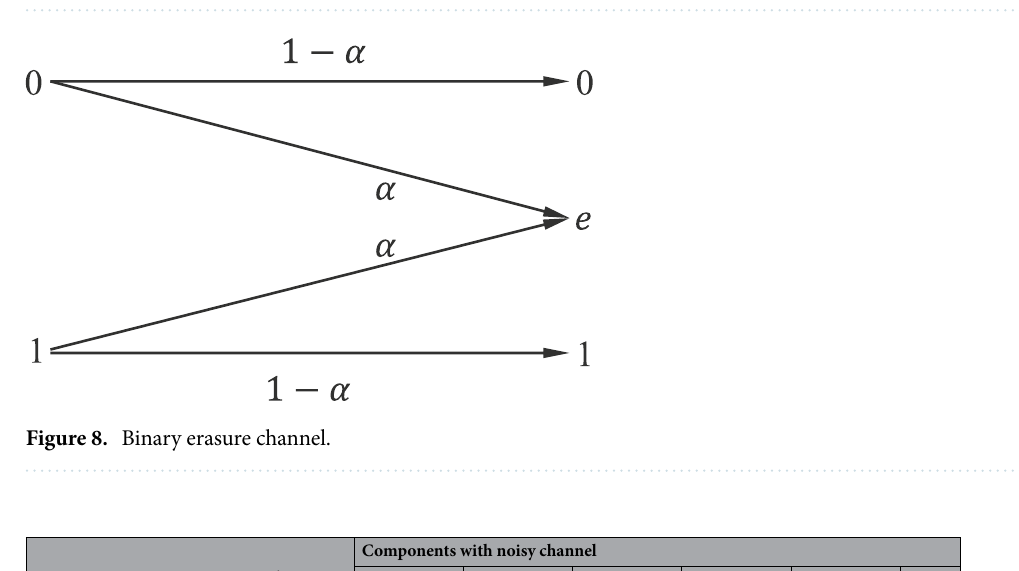
Figure 7. ( a ) The original image. ( b ) The reconstructed image when the component Y S is transmitted in the BSC. ( c ) The reconstructed image when the component Y D is transmitted in the BSC. ( d ) The reconstructed image when the component U S is transmitted in the BSC. ( e ) The reconstructed image when the component U D is transmitted in the BSC. ( f ) The reconstructed image when the component V S is transmitted in the BSC. ( g ) The reconstructed image when the component V D is transmitted in the BSC.